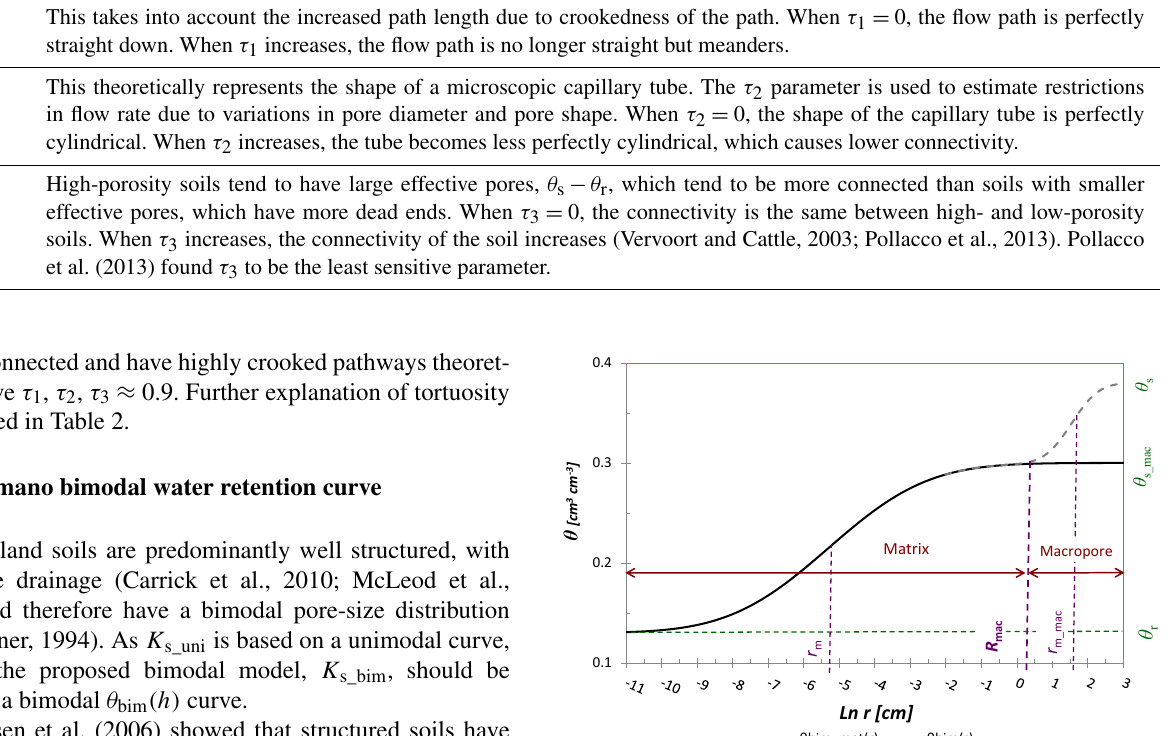
Table 2. Description of the tortuosity parameters. Tortuosity